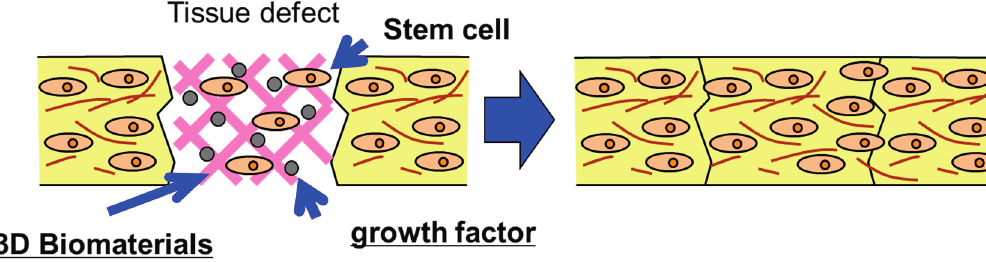
Figure 8. Schematic illustration of tissue engineering based on 3D biomaterials